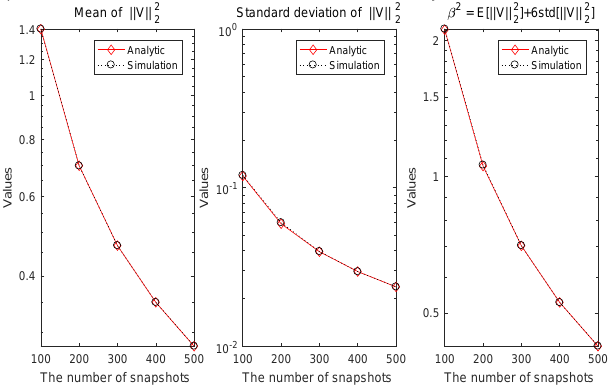
Figure 4. Comparison between the results of the analytic derivation and the results of Monte Carlo simulation (the number of elements of the transmitter = 10, the number of elements of the receiver = 14).